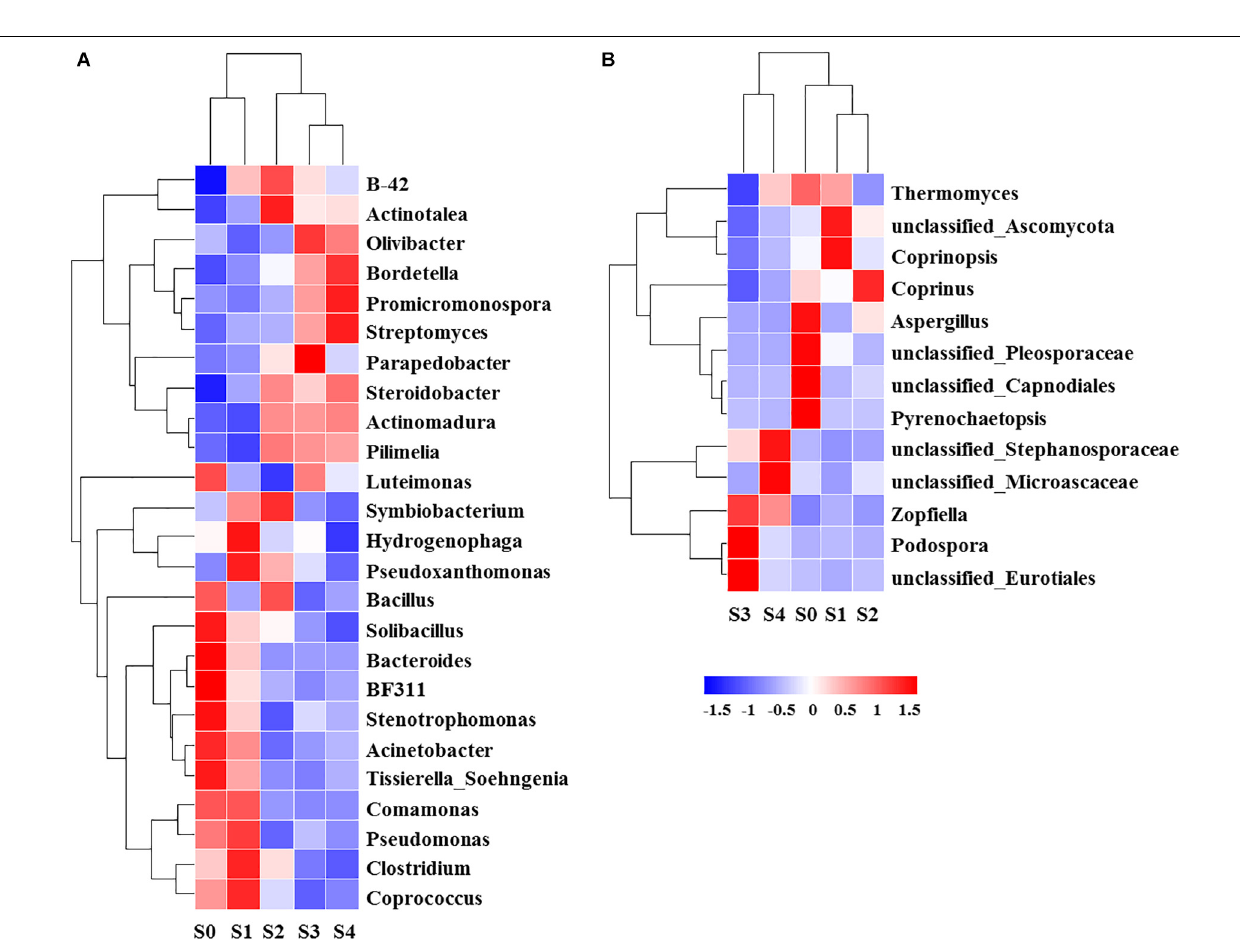
Frontiers in Microbiology |